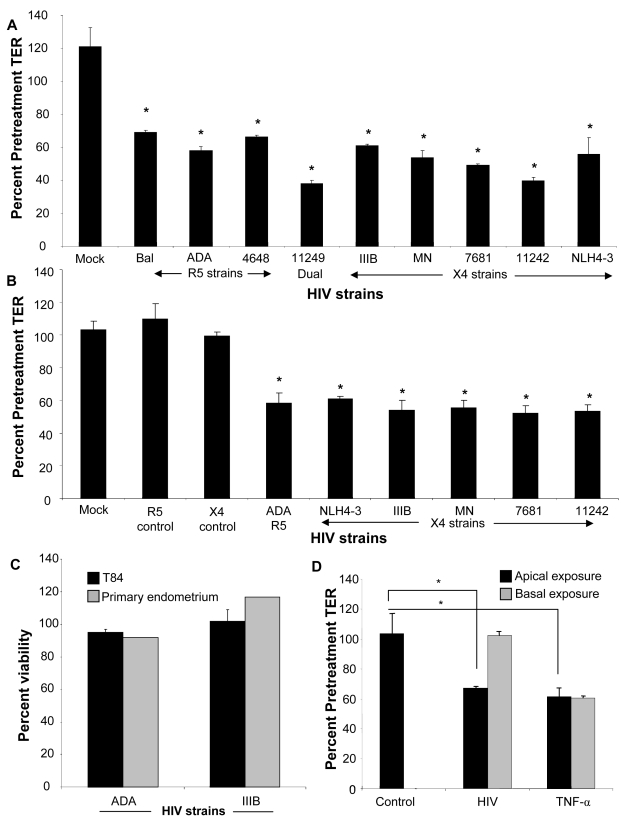
Primary endometrial epithelial monolayers (A) and T84 intestinal epithelial cell line (B) were exposed to 106 infectious viral units/ml of HIV-1 laboratory strains Bal, NL4-3, ADA (R5 tropic) and IIIB, MN (X4 tropic) and four clinical strains 4648 (R5 tropic) 11242, 7681 (X4 tropic) and 11249 (dual tropic).Corresponding p24 values were as follows for R5 tropic: Bal (0.6ng/ml), ADA (two different viral stocks 0.3 ng/ml and 1040 ng/ml), 4648 (49ng/ml); X4 tropic: IIIB (0.7ng/ml and 161ng/ml), MN (103ng/ml and 1110ng/ml), NLH4-3 (93ng/ml), 7681 (773ng/ml), 11242 (342ng/ml); dual tropic 11249 (200ng/ml). Control include cultures that were mock-treated with medium without virus (mock) or virus-free supernatants (R5 and X4 control). Transepithelial resistance (TER), was measured prior to and 24 hours post- exposure to HIV-1. *p<0.001, n = 3–9. Viability of primary female genital epithelial cells and T84 intestinal epithelial cells was assessed by MTT assay 24 hours after exposure with two HIV strains IIIB (X4-tropic) and ADA (R5-tropic) and compared with mock-infected epithelial monolayers (C). The effect of apical and basolateral exposure was determined. (D). Differentiated T84 epithelial monolayers were mock infected or exposed apically or basolaterally to HIV (ADA strain, 106 infectious viral particles/ml). TER was measured at 0, 24 and 48 hours post exposure. *P<0.001, **P<0.0001, n = 3.